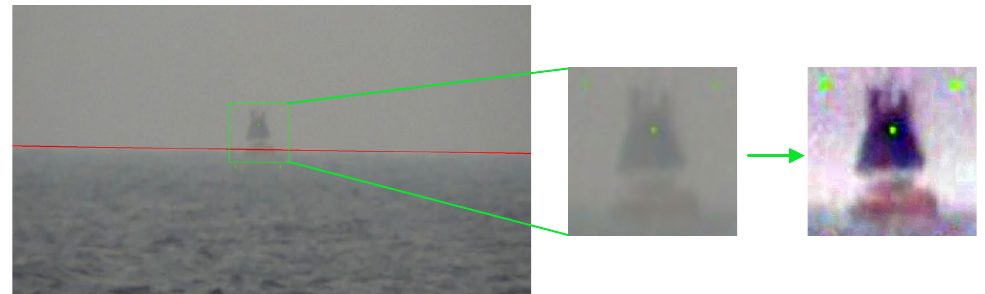
( b ) Figure 11. Target area extraction results: ( a ) target extraction process based on sea-sky line; ( b ) bright spot number curve based on sea-sky line. 2